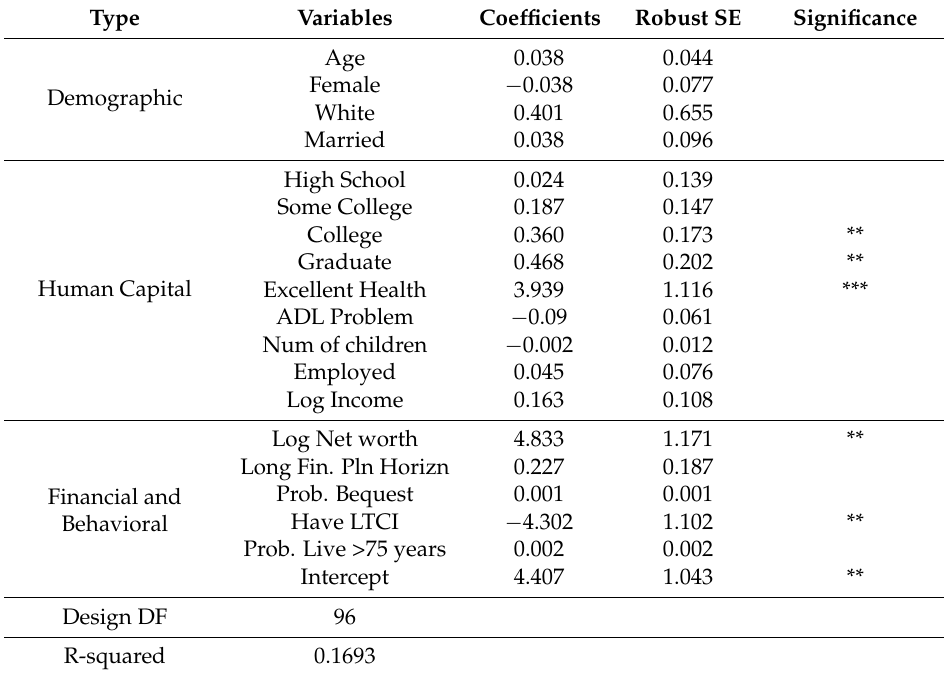
Table 4. Weighted ordinary least squares regression for the amount borrowed by the Reverse Mortgage